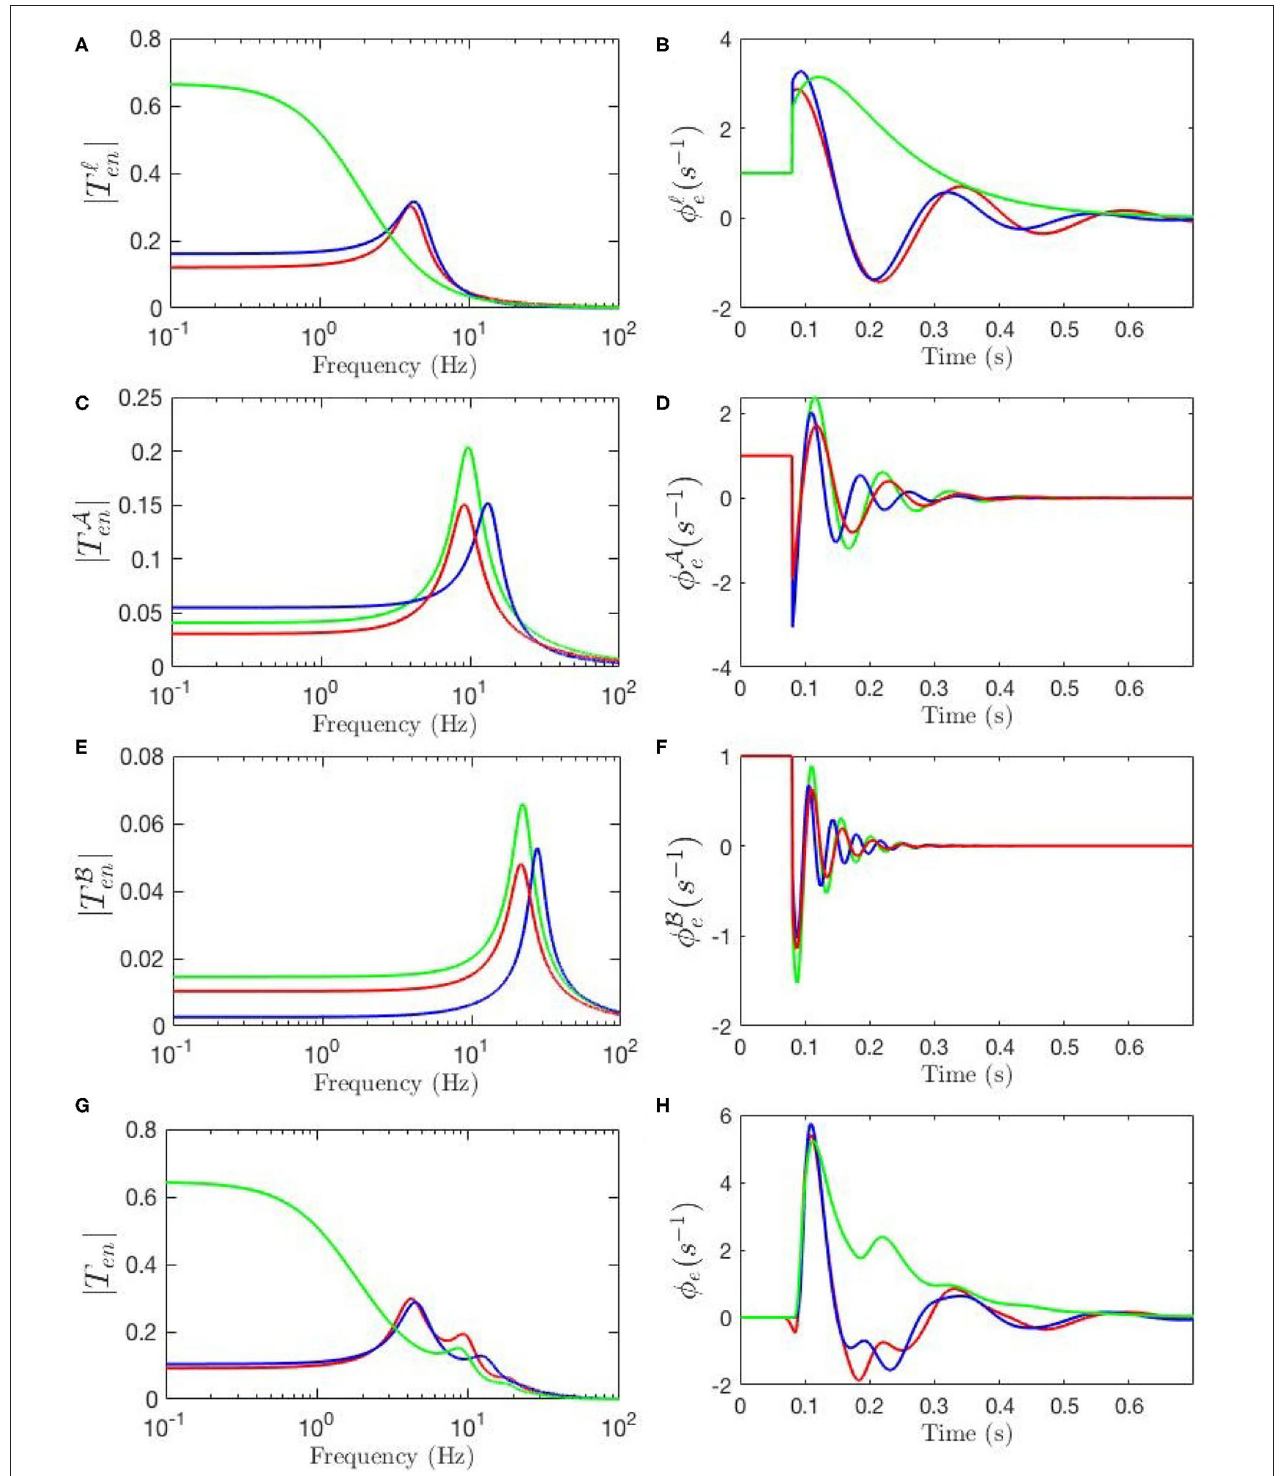
FIGURE 9 | Magnitudes of the transfer functions, their retrieved filters, and corresponding ERPs. Green lines denote fixed-gain resting EEG parameters, blue lines denote fixed-gain ERP from Kerr et al. (2011), and red lines show modulated gain parameters. (A) Magnitudes of low-frequency filters vs. frequency. (B) ERP Partial responses generated by low-frequency filters. (C) Magnitudes of alpha filters vs. frequency. (D) ERP partial responses generated by alpha filters. (E) Magnitudes of beta filters vs. frequency. (F) ERP partial responses generated by beta filters. (G) Magnitudes of full transfer functions vs. frequency. (H) ERP responses generated by full transfer